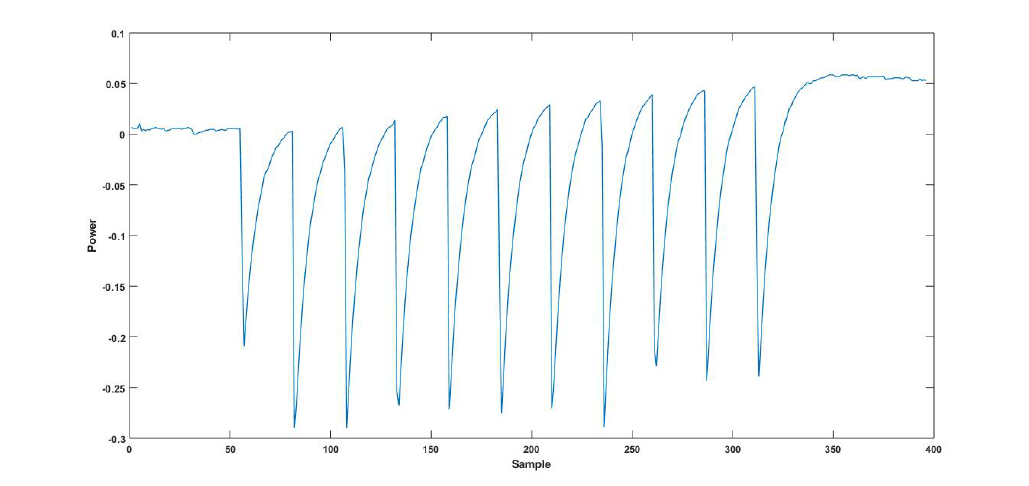
Figure 11. Power trace of AES RNS circuit.